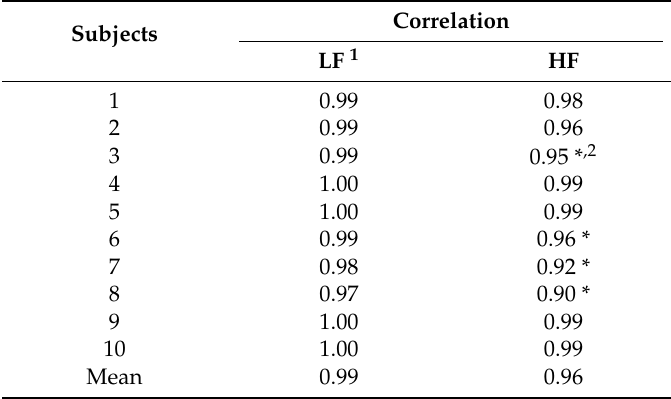
Table 4. Frequency domain HRV analysis comparison: PSD of SpaMA vs.